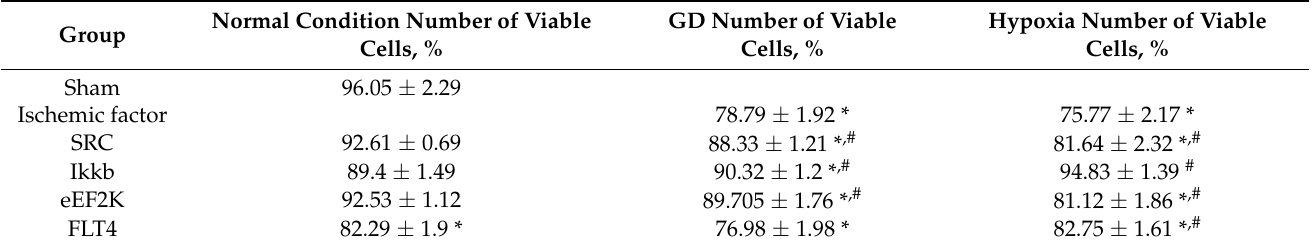
Table 1. Cell viability of primary hippocampal cultures on day 7 post-hypoxia or post-GD modeling with kinase blockers